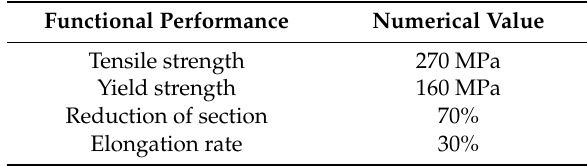
Table 3. Main functional performance parameters of the specimens.